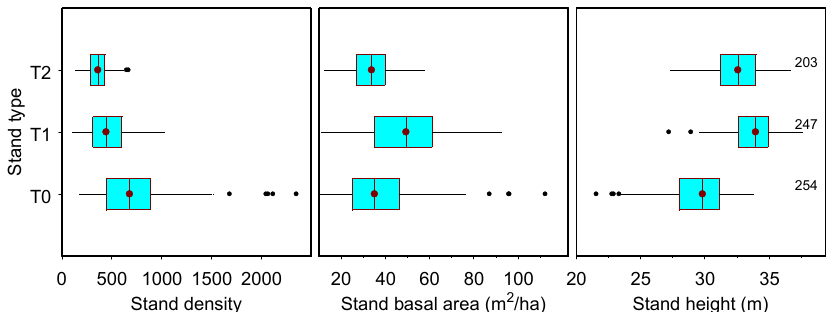
Figure 5. Boxplots of estimated stand-level attributes of individual grid cells for each of the three stand types. The number next to each boxplot on the right indicates the number of grid cells for the corresponding stand type.